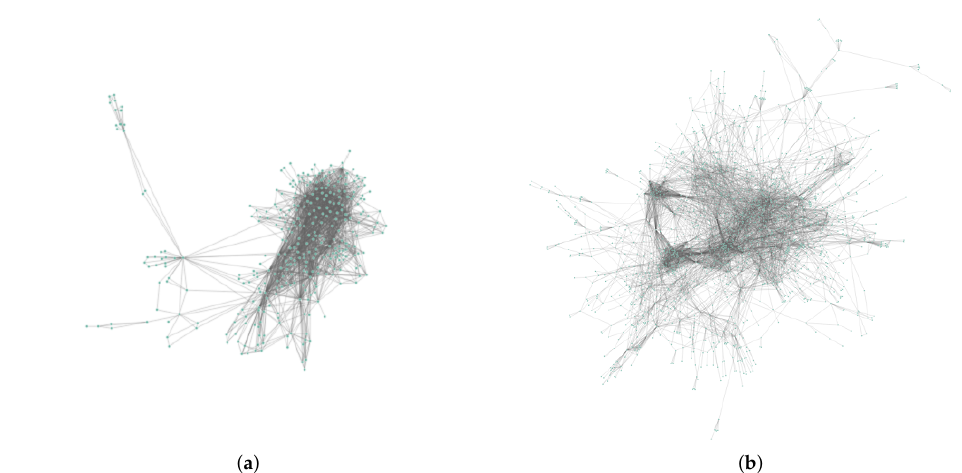
Figure 6. This figure shows the topological distribution of the real network in our network experiment. ( a ) Network topology of USAir97 network. ( b ) Network topology of technology routes network. Usually, when a network is attacked, the change in network efficiency can be used to measure the degree of damage to the